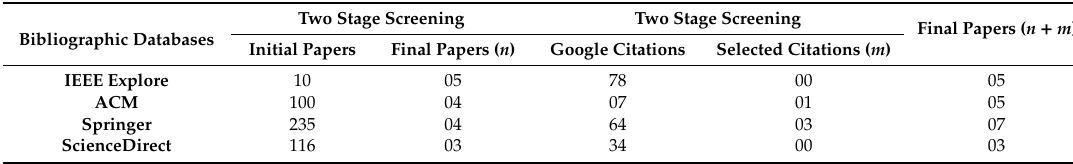
Table 1. Stages of screening of the studies.